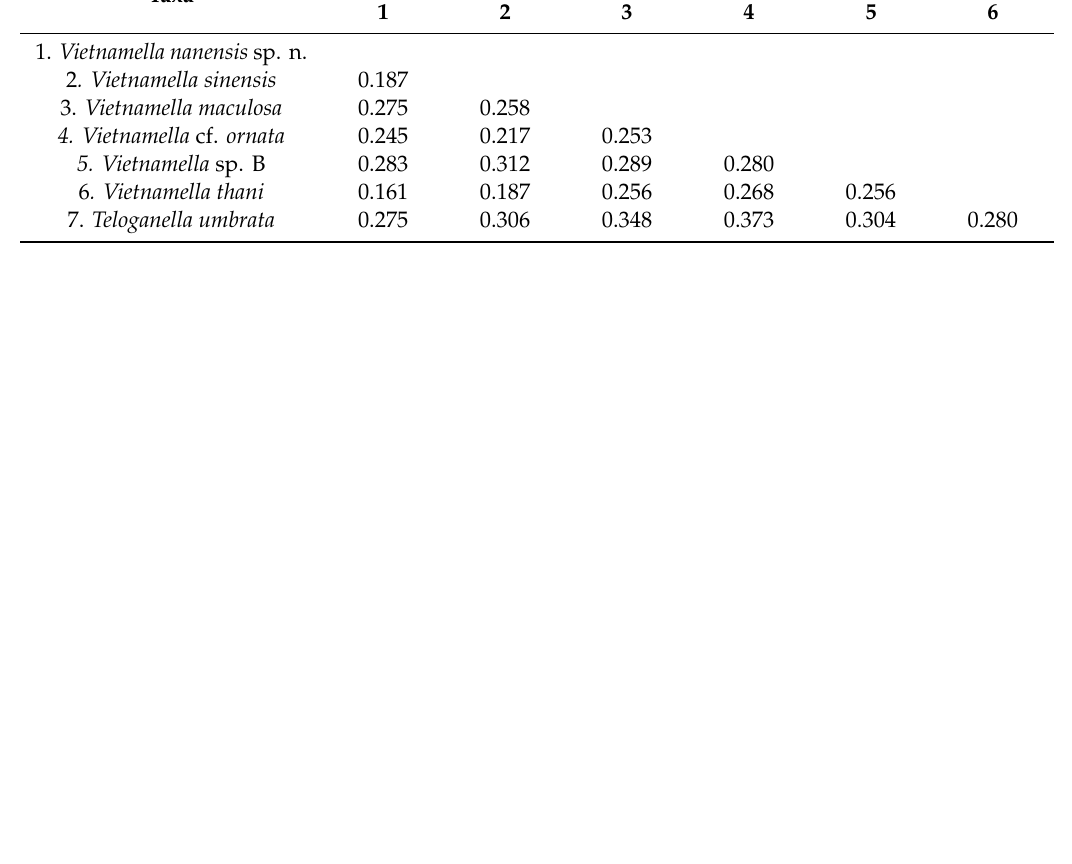
Table 2. Pairwise genetic distances (COI) between species of Vietnamella using the K2P.